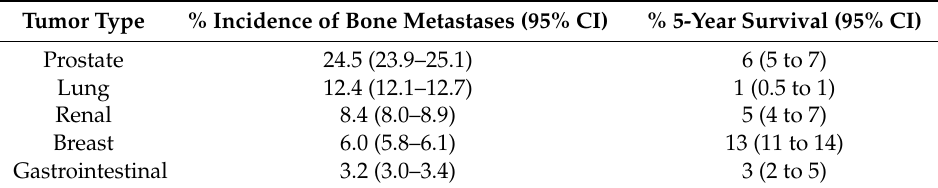
Table 1. Five-year incidence and survival of bone metastases by tumor type